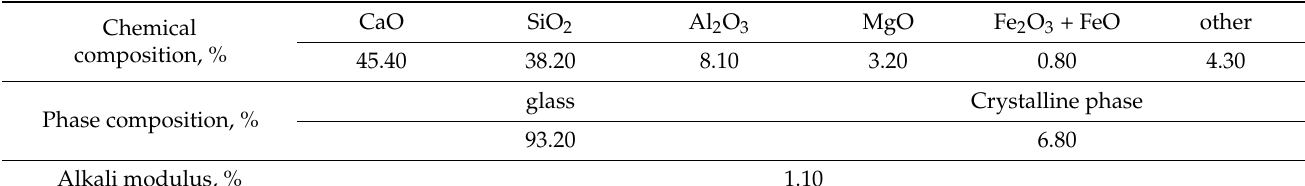
Table 4. GGBS characteristics.